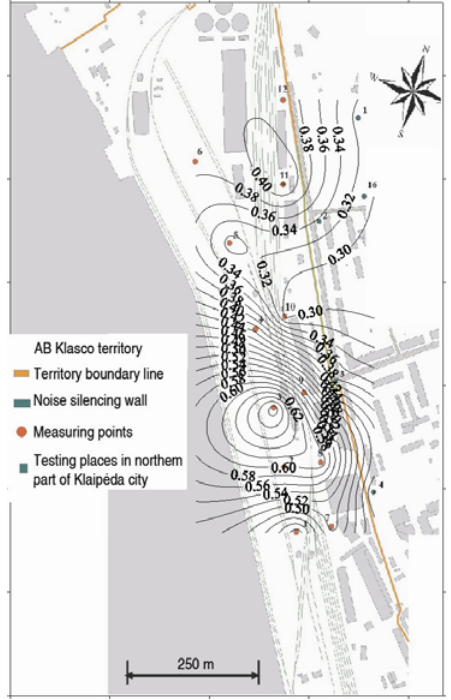
Fig 5 . Dustiness in the daytime in September In the evening on September 20 the highest concent- rations spread 250 metres along the quay as well as near the warehouses. The main reasons of such concentrations are works of ferroalloy loading in the main zone of loa- ding (points of measuring 2, 3 and 4) as well as traffic along the warehouses. (Fig 6). Concentrations in the terri- tory of the Seaport spread evenly from 0,24 mg/m 3 to 0,37 mg/m 3 downwind. During measuring the wind of 1,2 m/s was blowing, relative humidity was 79,5 %, air temperature was 14,2 °C. It was not detected any excess of concentrations during